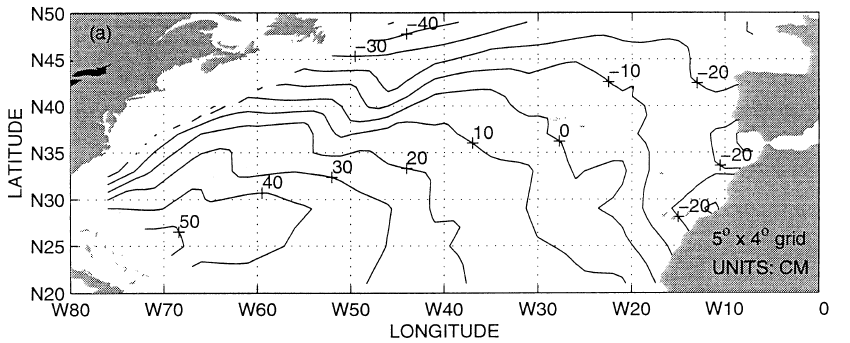
Fig. 2. Mean dynamic topography calculated on the 5 (cid:176) longitude (cid:180) 4 (cid:176) latitude grid using T/ P observations of the mean sea surface height and the JGM-2 geoid height